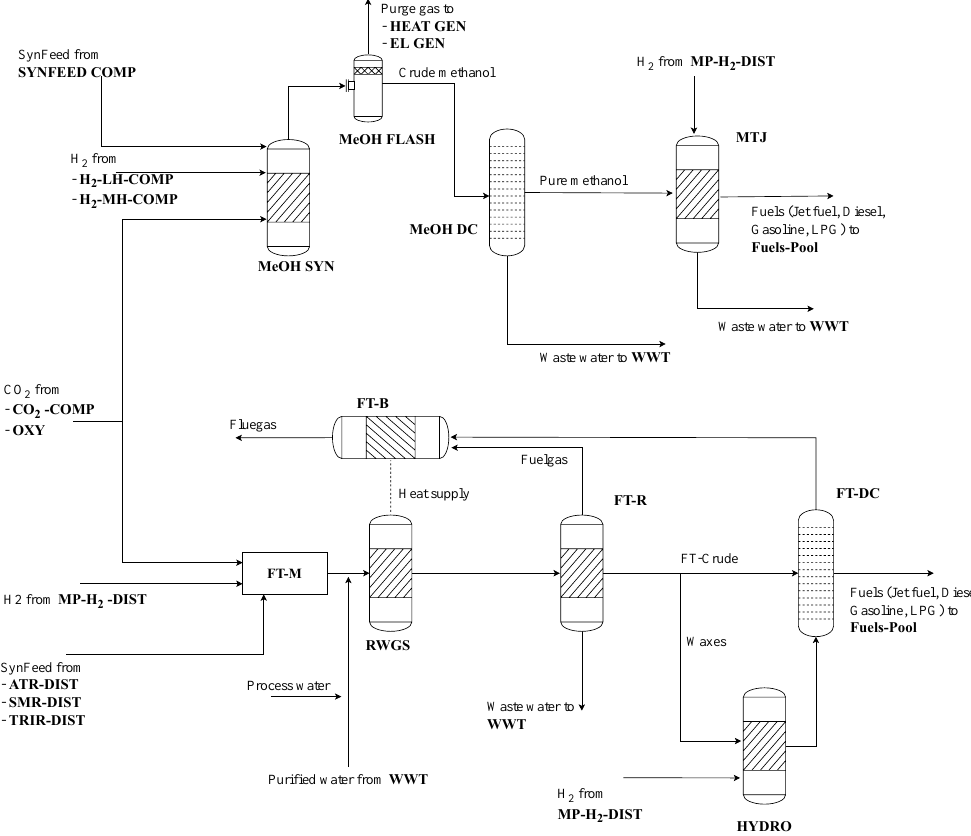
Figure 4. Thermochemical synthesis and upgrading process section of renewable refinery superstructure.